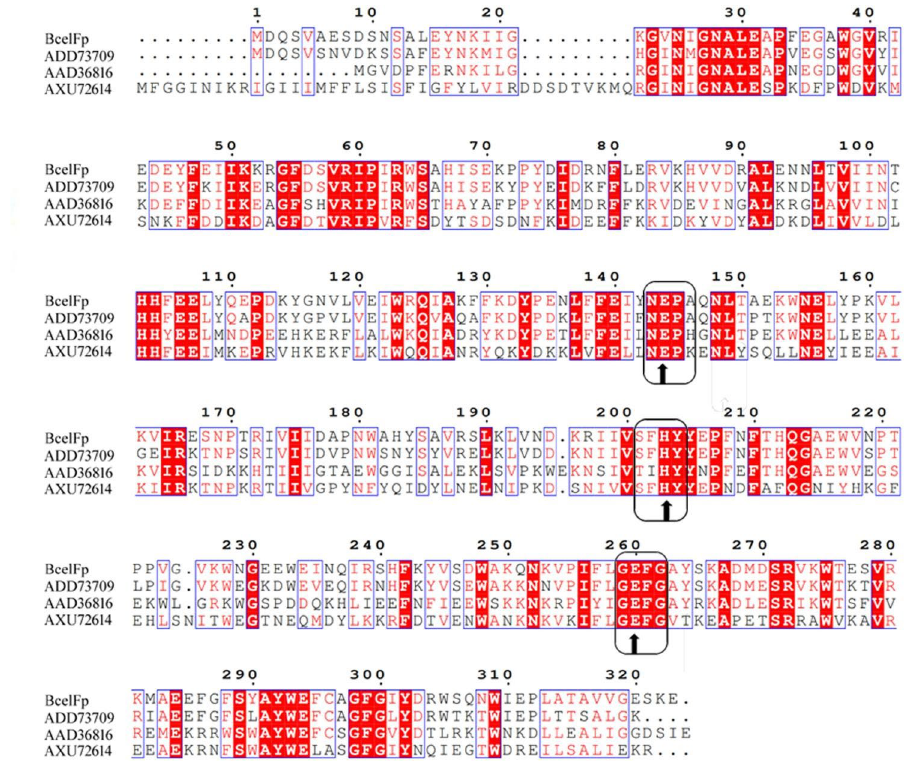
Fig. 2 Multiple amino acid sequence alignment of BcelFp with several characterized glycoside hydrolases from GH5. The accession numbers of the aligned sequences are for the following organisms: ADD73709, endoglucanase FnCel5A from Fervidobacterium nodosum Rt17-B1; AAD36816, endoglu- canase from Thermotoga maritima MSB8; AXU72614. endoglucanase from Clostridioides difficile . The accession numbers were indicated to the left of the amino acid sequences. Identical residues are indicated by a red background. Symbols: ↑ amino acids forming a catalytic